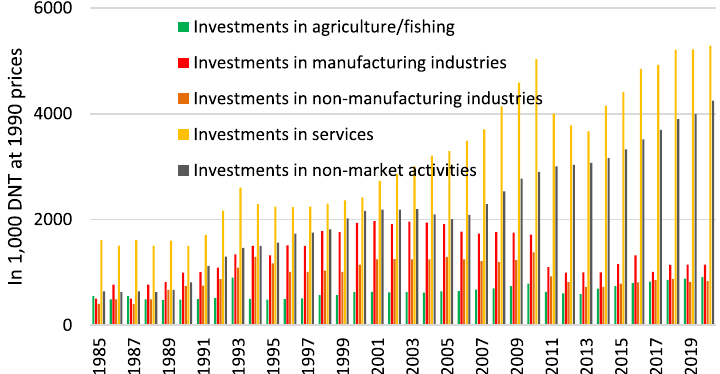
Fig. 7 Evolution of cumulative gross fixed capital formation by economic activity at 1990 prices. Source Compiled by the author from data collected from several issues of the Statistical Yearbook of Tunisia